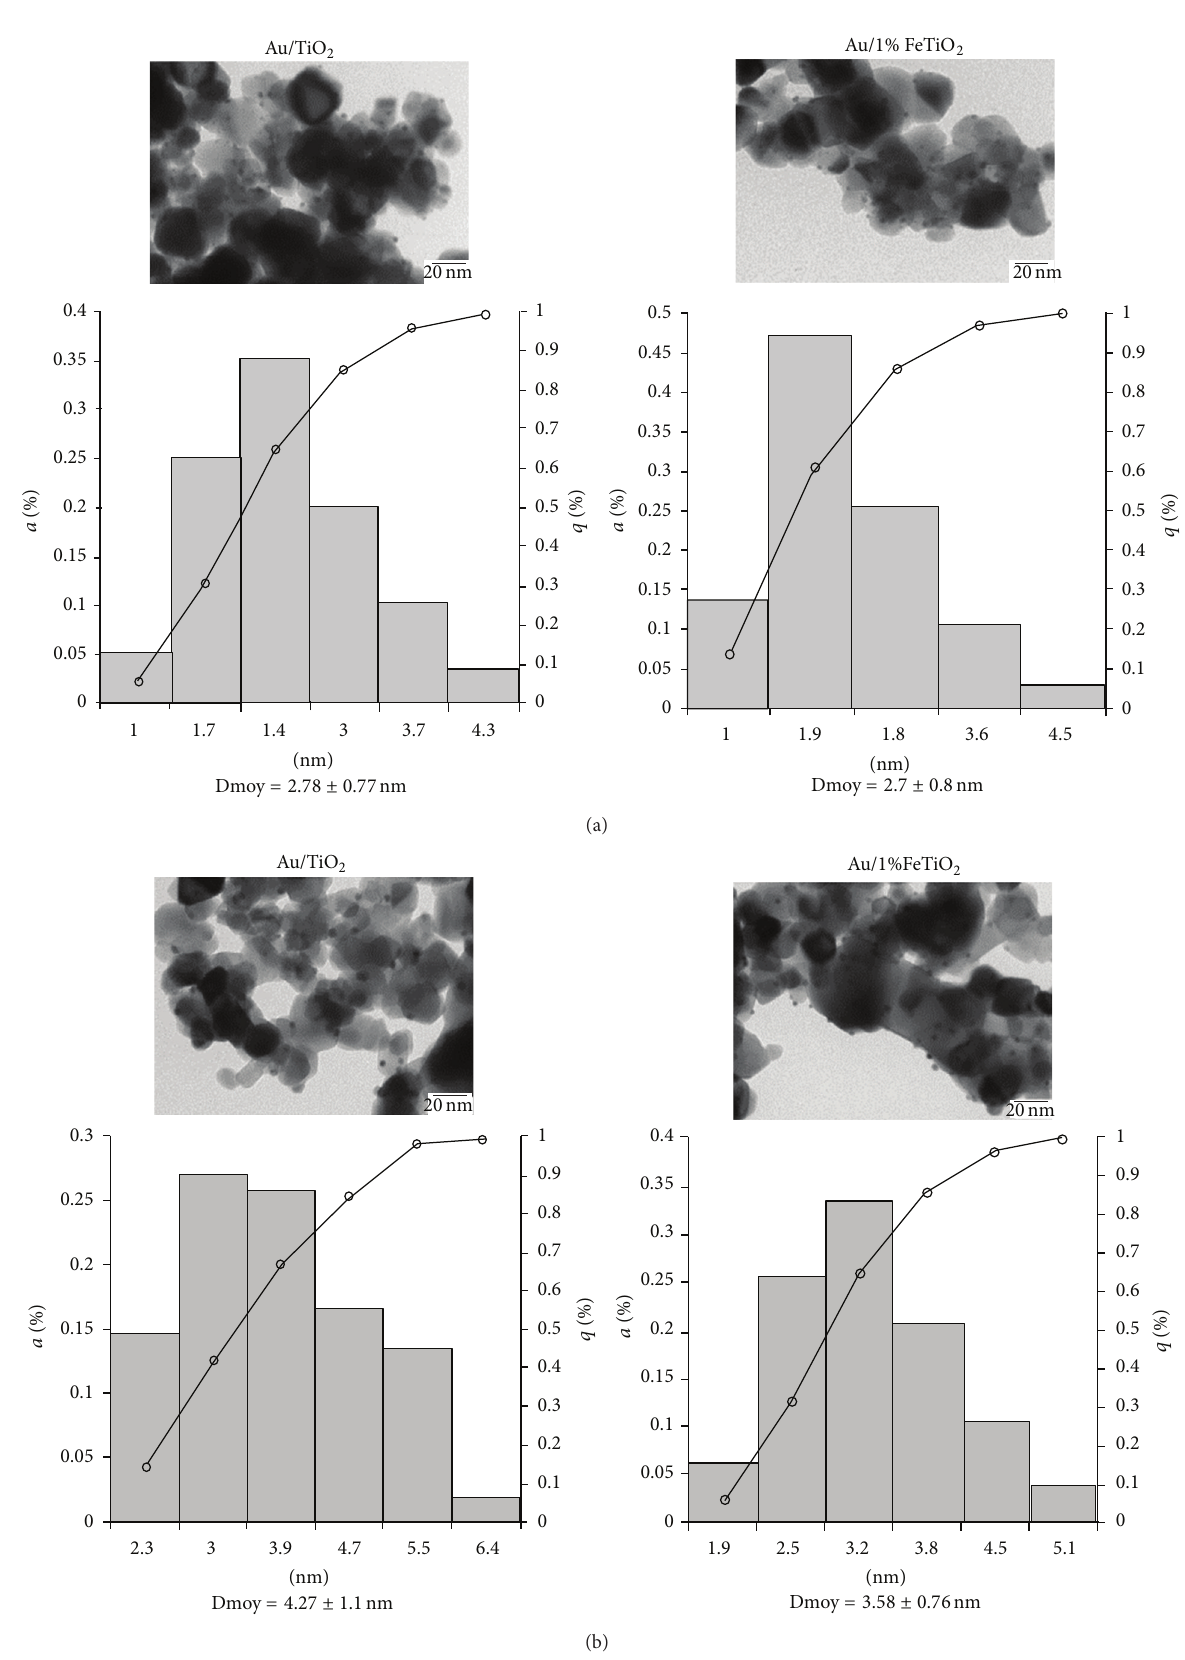
Figure 1: TEM analysis of gold supported on TiO 2 and 1% FeTiO 2 before (a) and after (b) thermal treatment